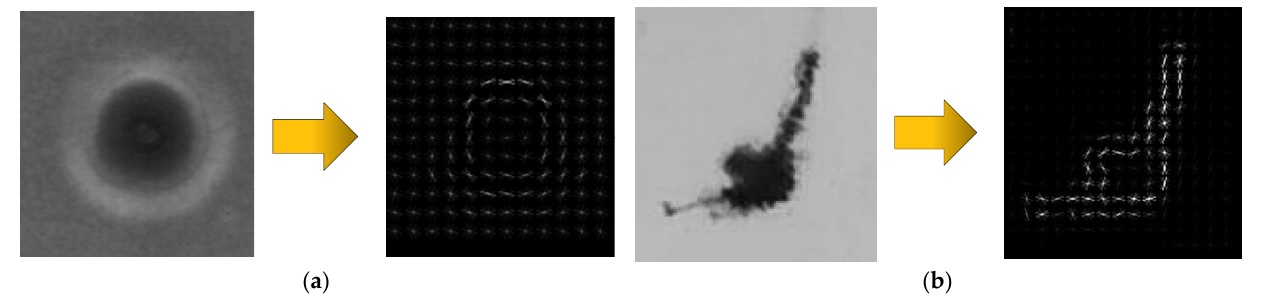
Figure 9. Examples of HOG characteristics of a bubble and an impurity. ( a ) Bubble HOG feature extraction result; ( b ) Impurity HOG feature extraction result.